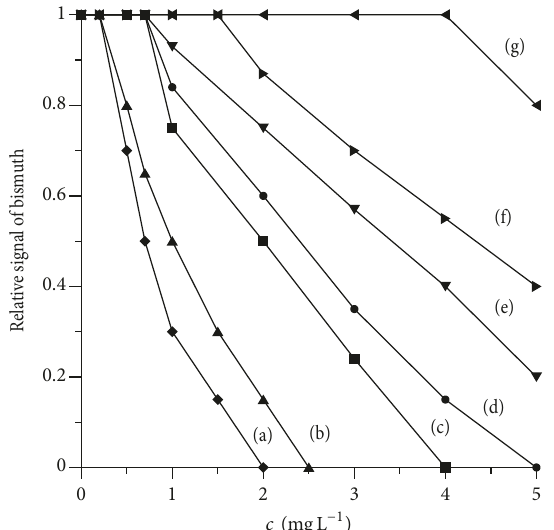
Figure 4: The influence of Triton X-100 (a), Rhamnolipid (b), HA (c), CTAB (d), FA (e), NOM, (f) and SDS (g) on 2 × 10 −8 molL −1 Bi(III) peak current. Concentration of cupferron 1 × 10 −4 molL −1 and acetate buffer 0.1mol L −1 (pH = 4.5). Accumulation potential − 0.05 V and accumulation time 30 s.